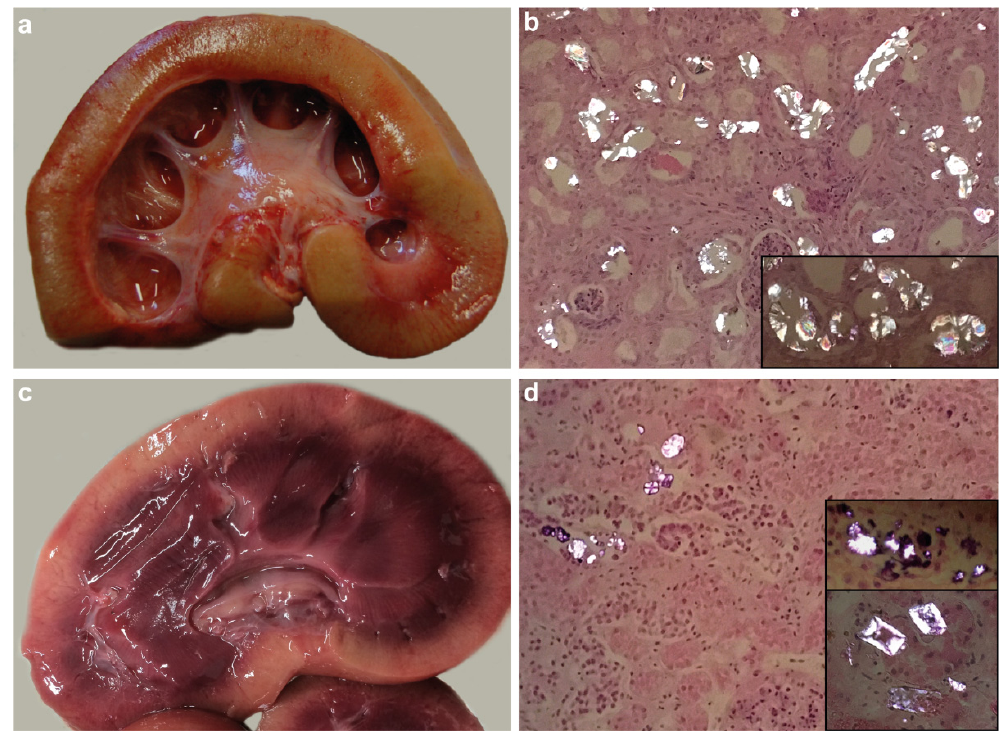
Figure 1. Macroscopic and histopathological findings in two Zwartbles sheep. ( a ) Kidney of case 3 showing the near-complete loss of corticomedullary demarcation and prominent dilation of the pelvis. ( b ) Numerous crystals in the renal tubules of case 3 are brightly birefringent when viewed by polarized light; the morphology is typical of oxalate (inset). ( c ) Kidney of case 4 showing cortical pallor and clear corticomedullary demarcation. ( d ) Sparse birefringent crystals in the renal tubules of case 4; the morphology is variable with some not typical of oxalate crystals (inset).